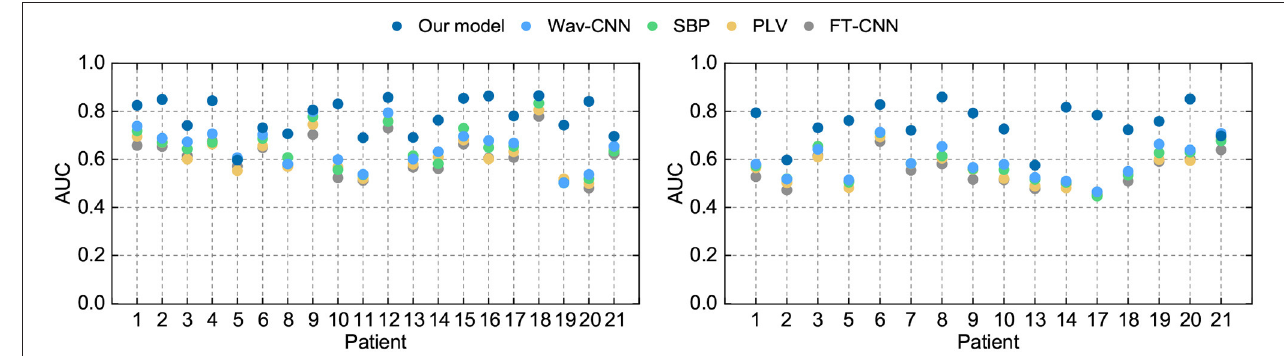
FIGURE 5 | AUC of different seizure prediction models on the Freiburg Hospital test set (left) and the CHB-MIT test set (right)